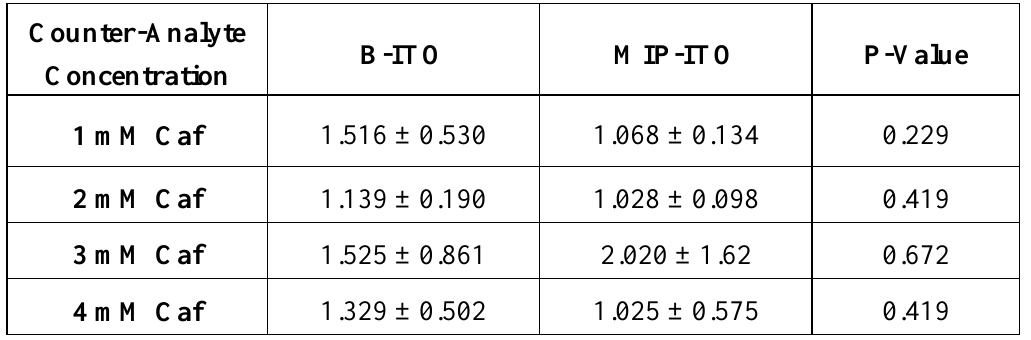
Table 2. Ratio of Minimum Currents of B-ITO and MIP-ITO Sensor at Various Counter